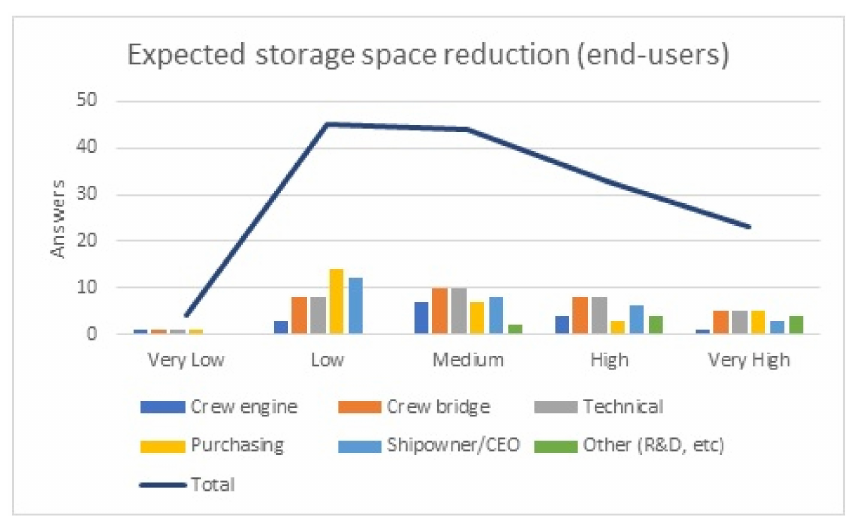
Figure 4. Expected storage space